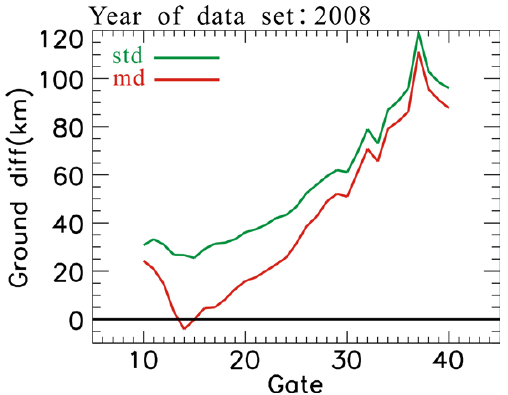
Fig. 6. The standard deviation (green lines) and the mean deviation (red lines) of ground range between the results of standard Super- DARN model and the ray tracing for the data set in